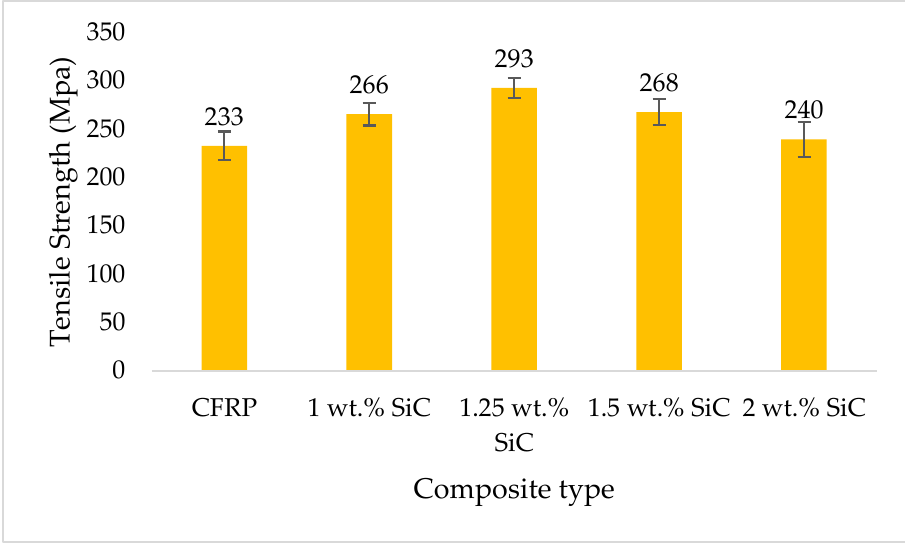
Figure 8. Tensile strength of CFRP and hybrid SiC nano-composites.